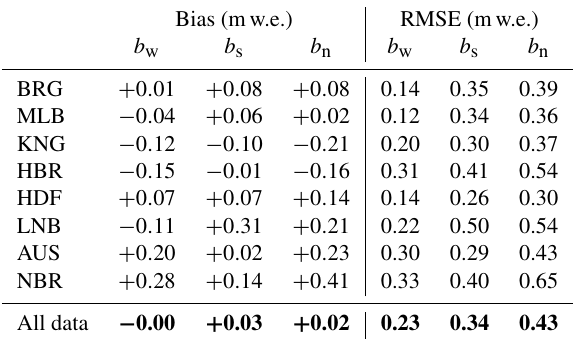
Table 2. Comparison of simulated and observed b w , b s , and b n after calibration. Biases and RMSE values for all data are given in bold. Bias (mw.e.) RMSE